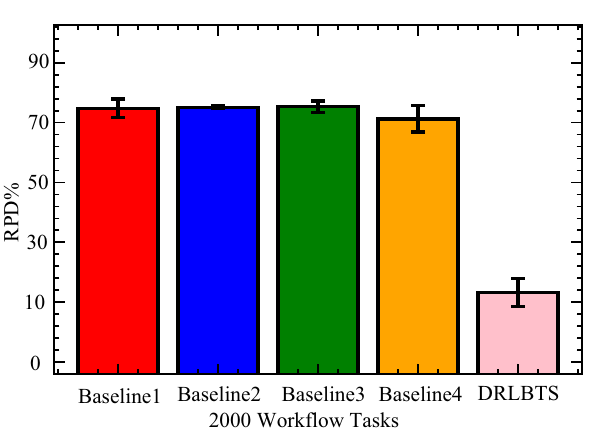
Figure 6. Adaption performance of scheduling schemes for workflows.